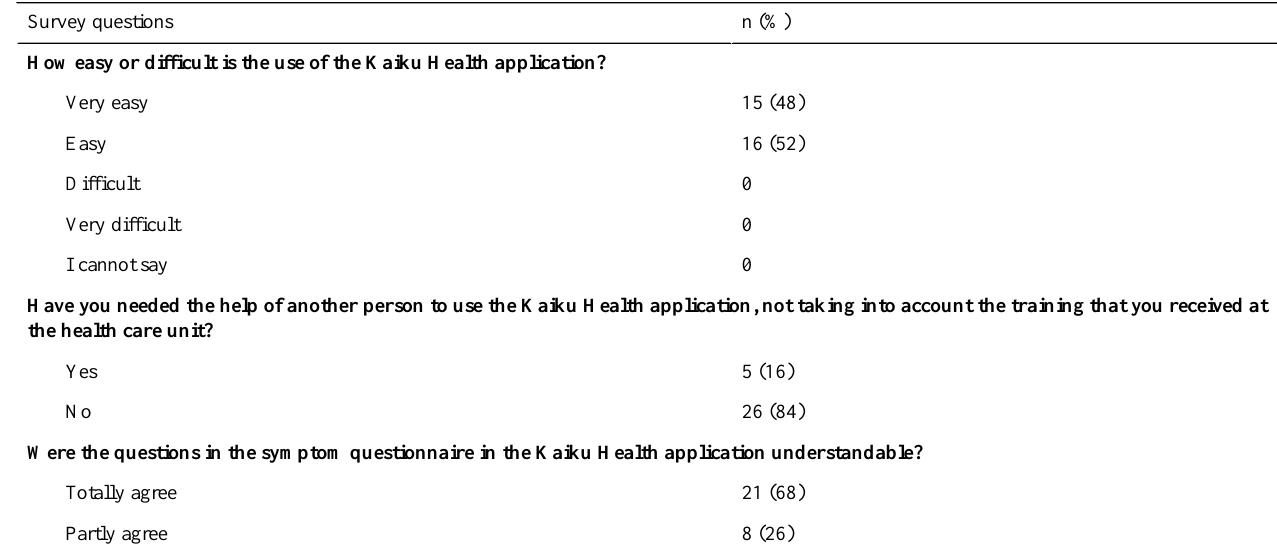
Table 5. Kaiku Health patient experience survey results during the first 12 weeks of follow-up (n=31).